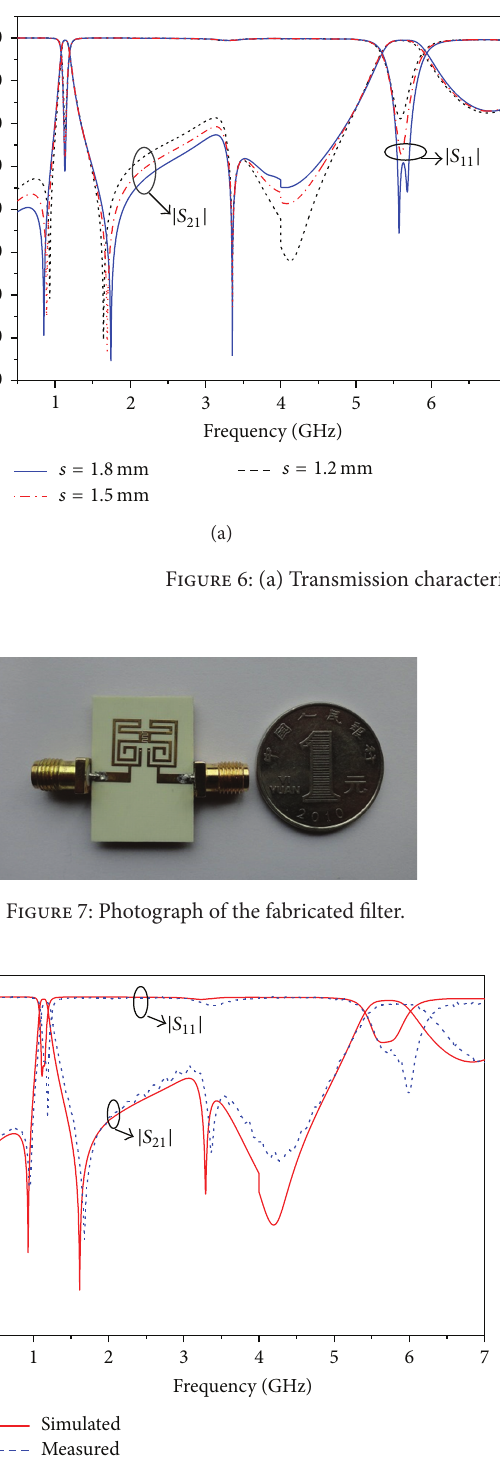
Figure 8: Simulated and measured S -parameters.